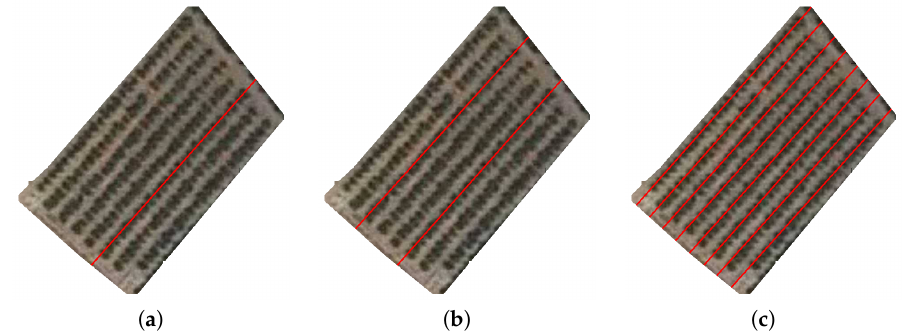
Figure 6. Detecting tree rows with Hough. ( a ) current parcel view with the first detected row, ( b ) current parcel view with the first and second detected rows, ( c ) current parcel view with all detected rows.